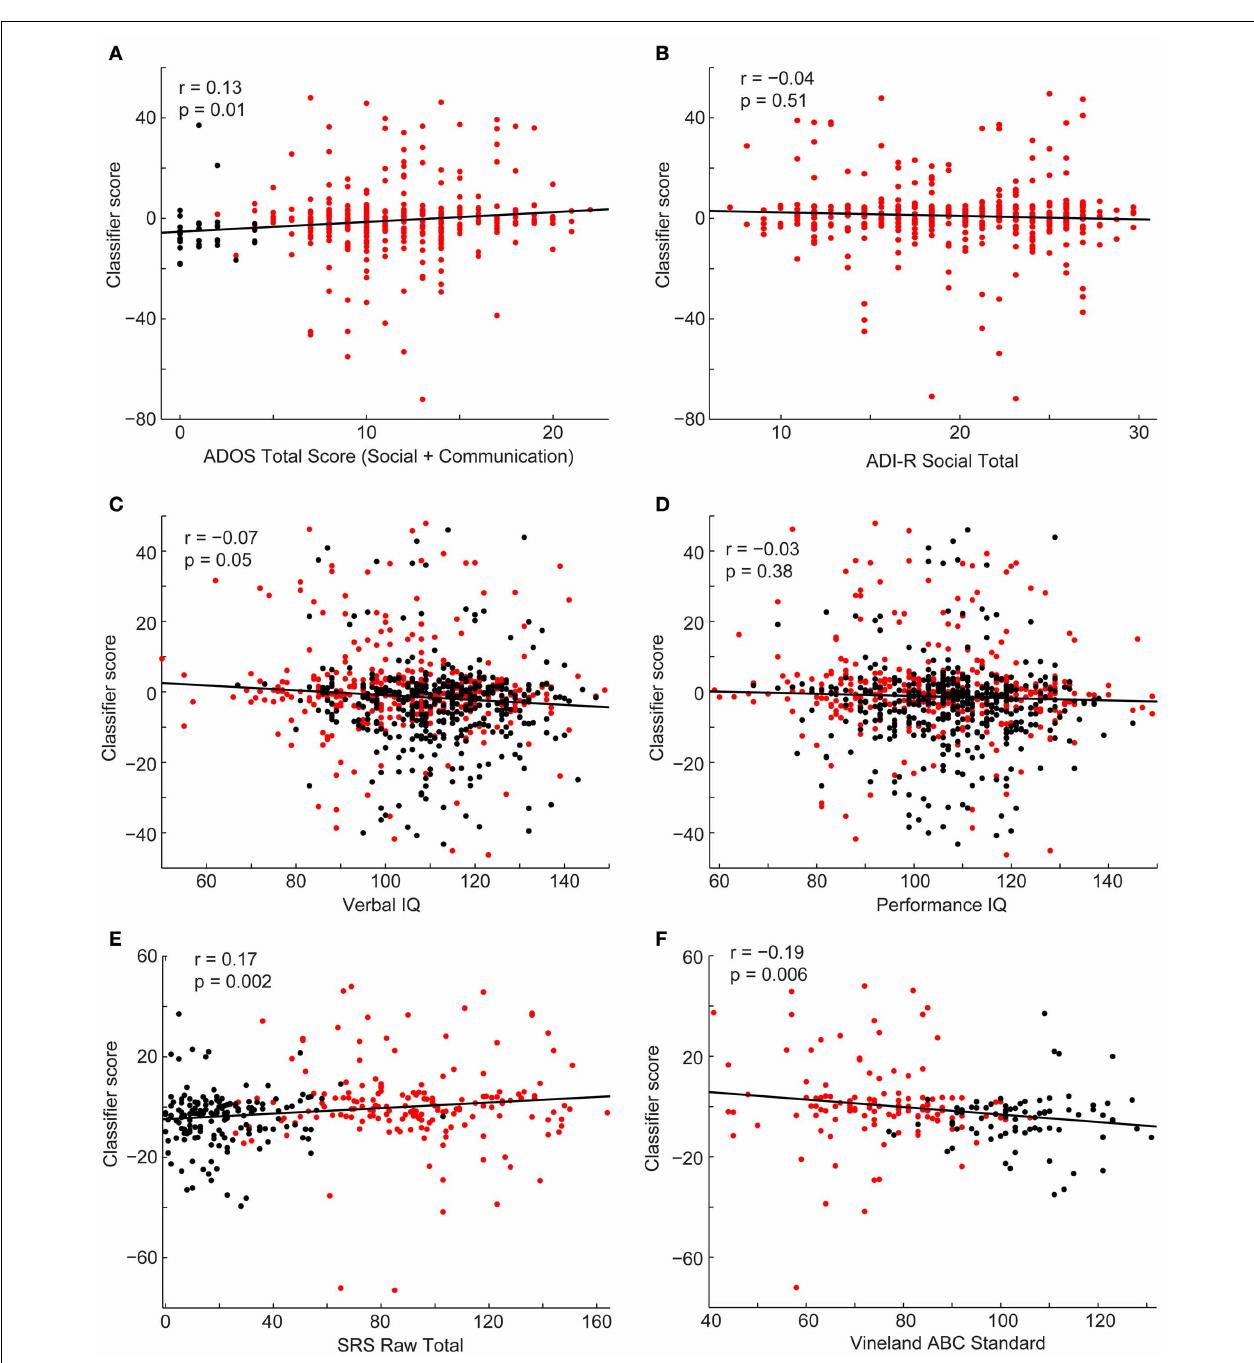
FIGURE 7 | Scatterplots depict the relationship between the classifier scores for control subjects (black) and subjects with autism (red) and the following behavioral measures: ADOS-G social + communication algorithm score (A), ADI-R social verbal